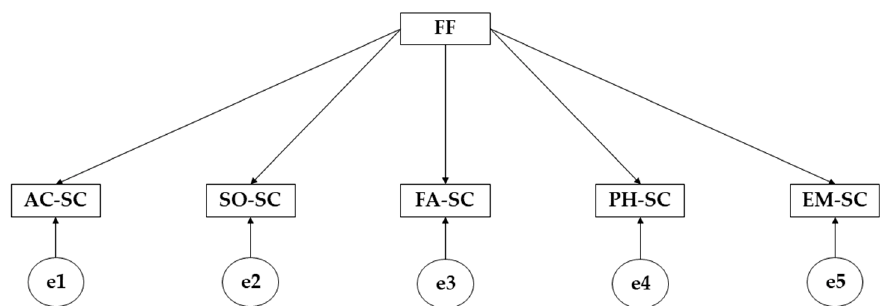
Figure 1. Proposed structural equation model. Note: Family functionality (FF); Academic self- concept (AC-SC); Social self-concept (SO-SC); Family self-concept (FA-SC); Physical self-concept (PH-SC); Emotional self-concept (EM-SC).